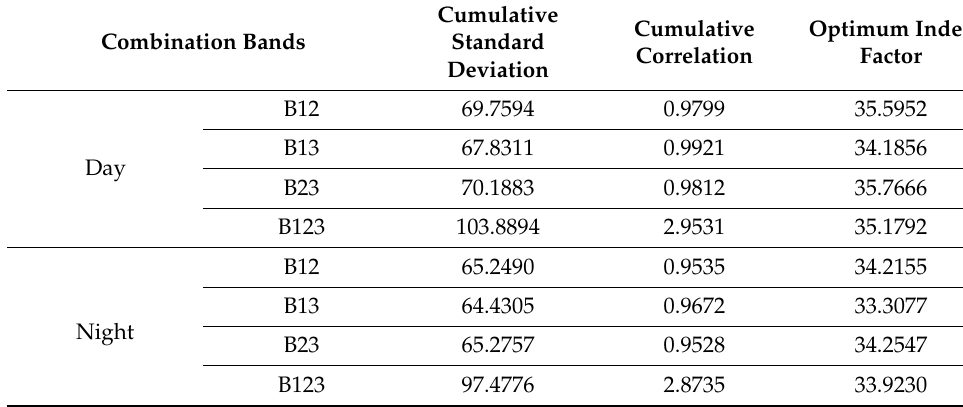
Table 5. The summary of dataset feature